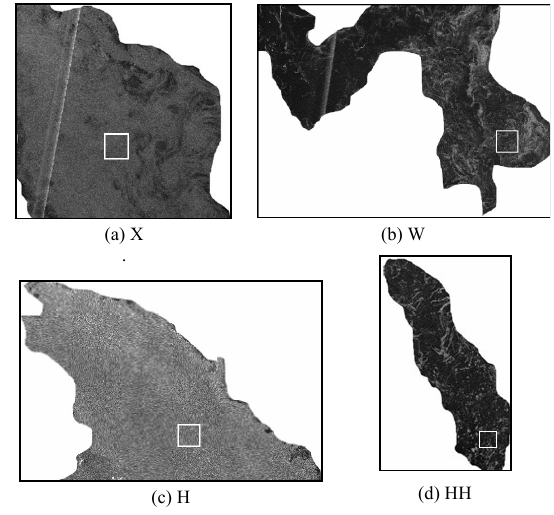
Fig. 9 Polygons cut out from Fig. 8. The white squares of each polygons refer to the samples in Fig. 10